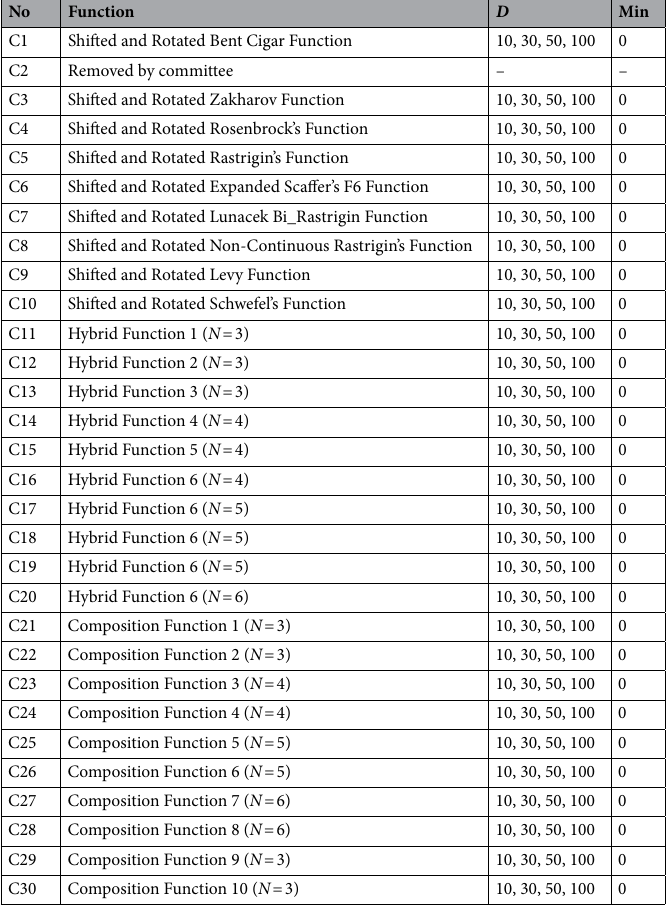
Table 12. Summary of the CEC-2017 test functions.